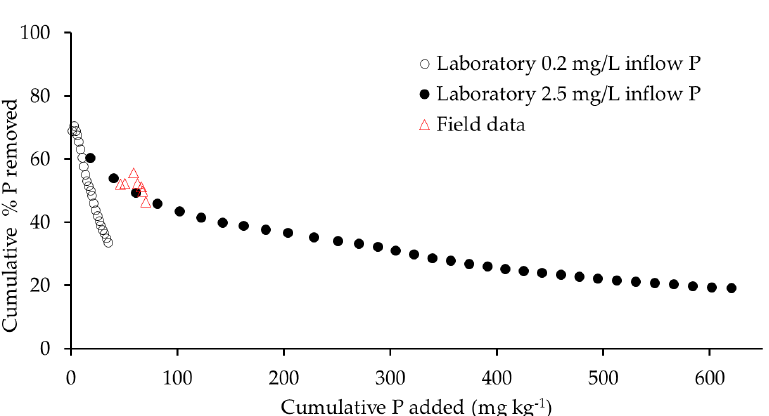
Figure 3. Cumulative dissolved phosphorus (P) removed by the slag under laboratory flow-through conditions (10 min retention time) at two different concentrations, compared to measured P removal in the blind inlet. Results expressed as a function of the cumulative P added per kg slag.